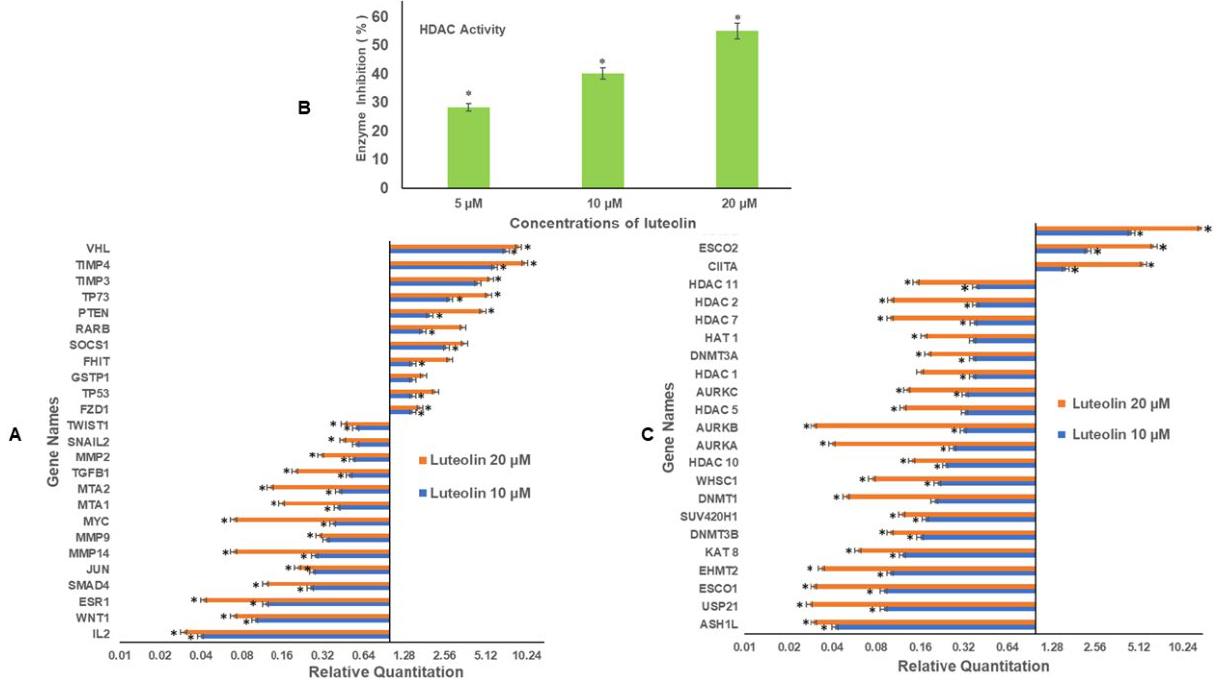
Figure 2. ( A ). Luteolin modulated the expression of various TSGs and migration related genes in a dose-dependent manner. The TSGs were upregulated, whereas inflammatory and migration-related genes were downregulated. ( B ). Luteolin inhibited HDAC activity in HeLa cells in a concentration- dependent manner in comparison with the untreated control. The values were taken as mean of three experiments ± SD (* represents that data is statistically significant with p ≤ 0.05). ( C ). Treatment of HeLa cells with luteolin at 10 and 20 µM for 48 h modulated the expression of epigenetic enzymes in a dose-dependent manner (* represents that data is statistically significant with p ≤ 0.05).